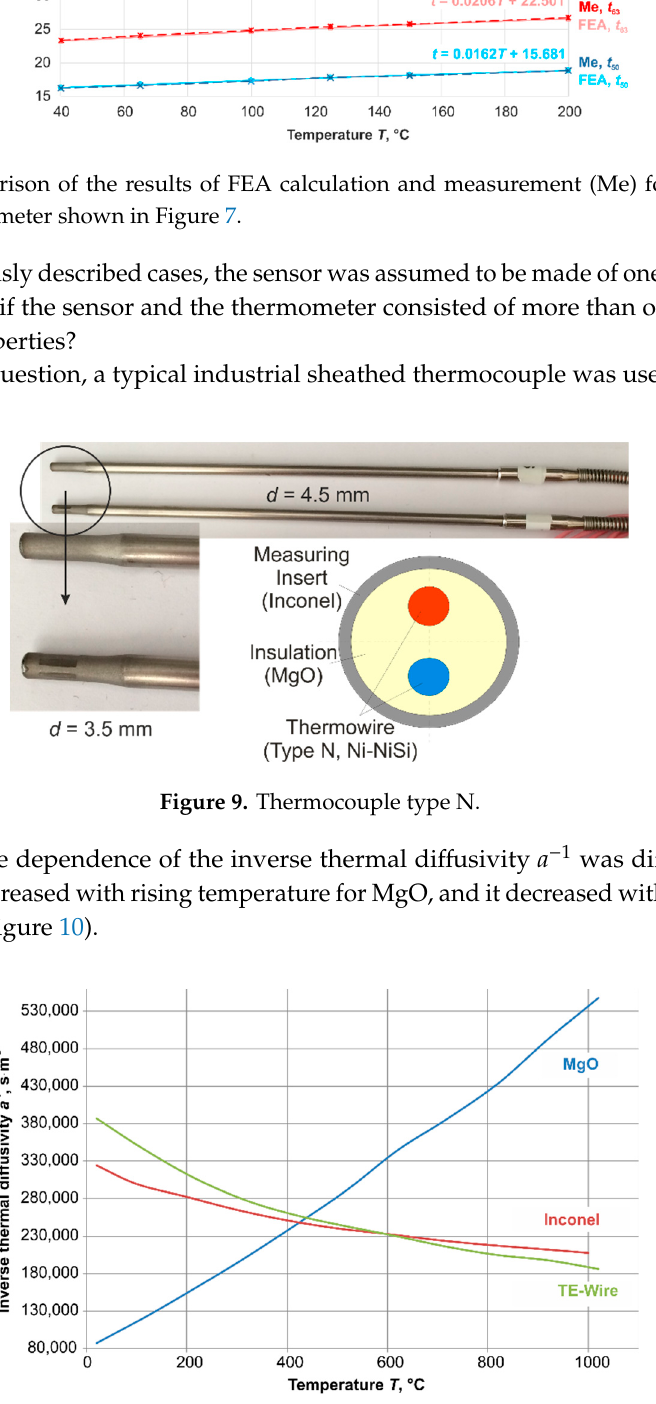
Figure 10. Inverse thermal diffusivity a − 1 of the materials used [10,12,13].